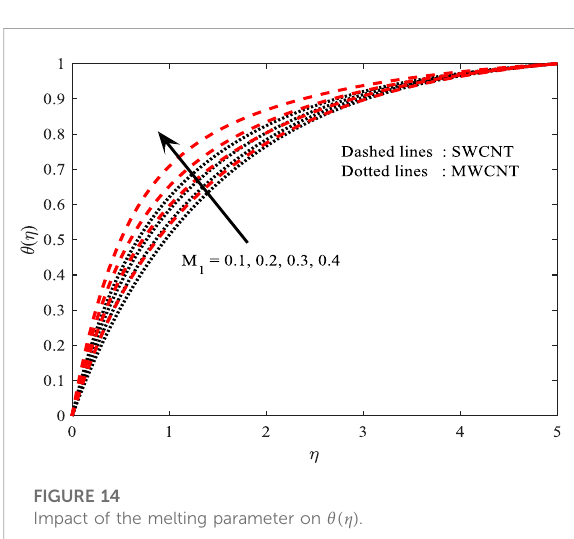
FIGURE 11 Impact of Prandtl number on θ p ( η ) .